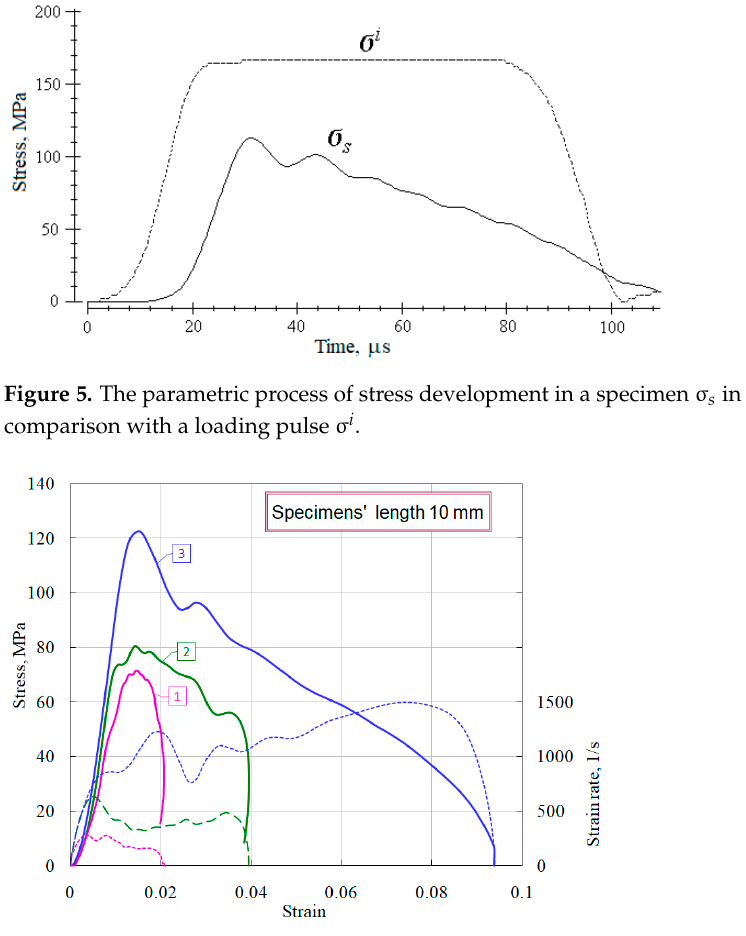
Figure 6. Deformation diagrams of ceramic specimens of optimal geometry under compression.